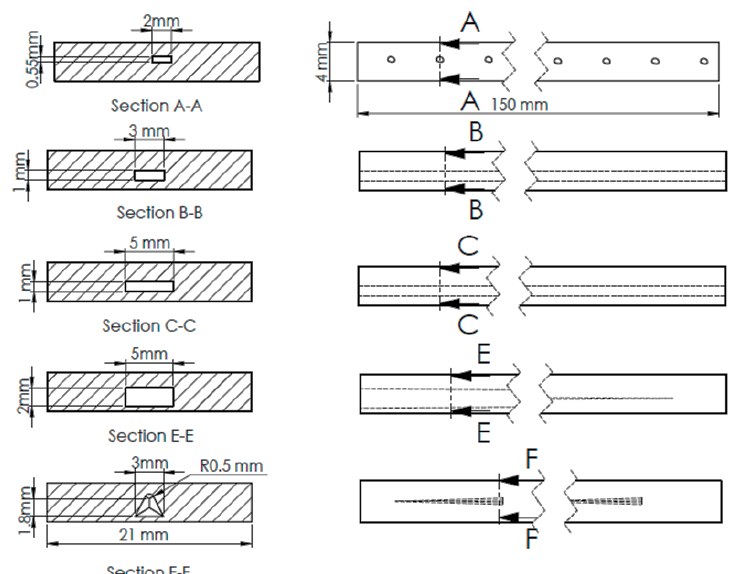
Figure 12. Different designs of FSW defects used in finite element analysis (FEA) simulation. ( A ) linear porous defect, ( B ) regular tunnel type B, ( C ) regular tunnel type C, ( E ) taper rectangle tunnel, and ( F ) intermittent taper triangle tunnel.